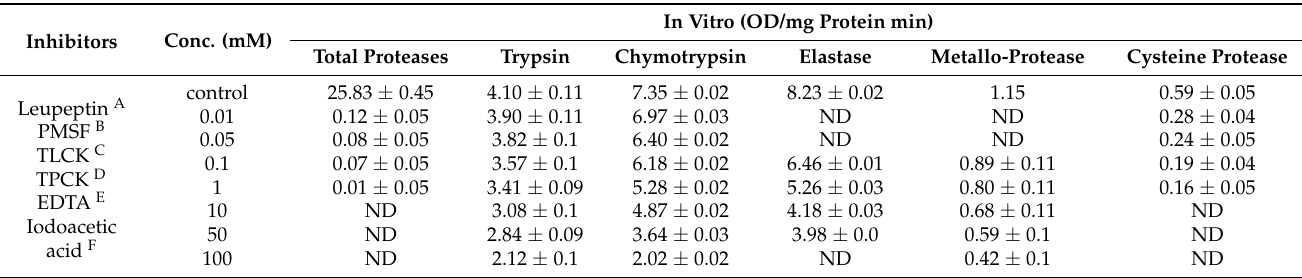
(A) Inhibitor of general proteinase; (B) a general serine proteinase inhibitor (Elastase); (C) inhibitor of Trypsin; (D) TPCK as a chymotrypsin inhibitor; (E) an inhibitor of metalloprotease; (F) an inhibitor of cysteine protease; data are expressed as mean ± SE based on three replicates per tested concentration; ND: Not